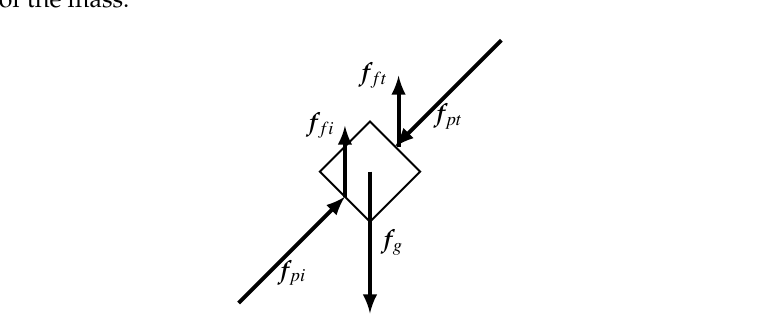
. Friction f f i , t i , t { } { }